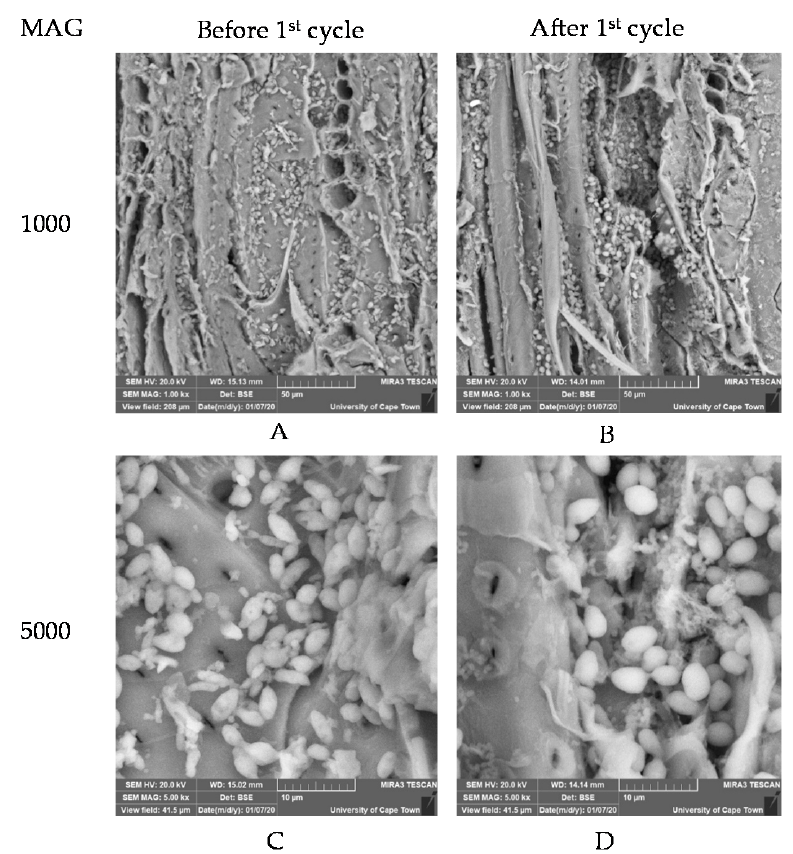
Figure 4. Scanning electron micrographs of oak wood chips before and after first cycle fermentations at 1000× ( A , B ) and 5000× ( C , D ) magnifications.